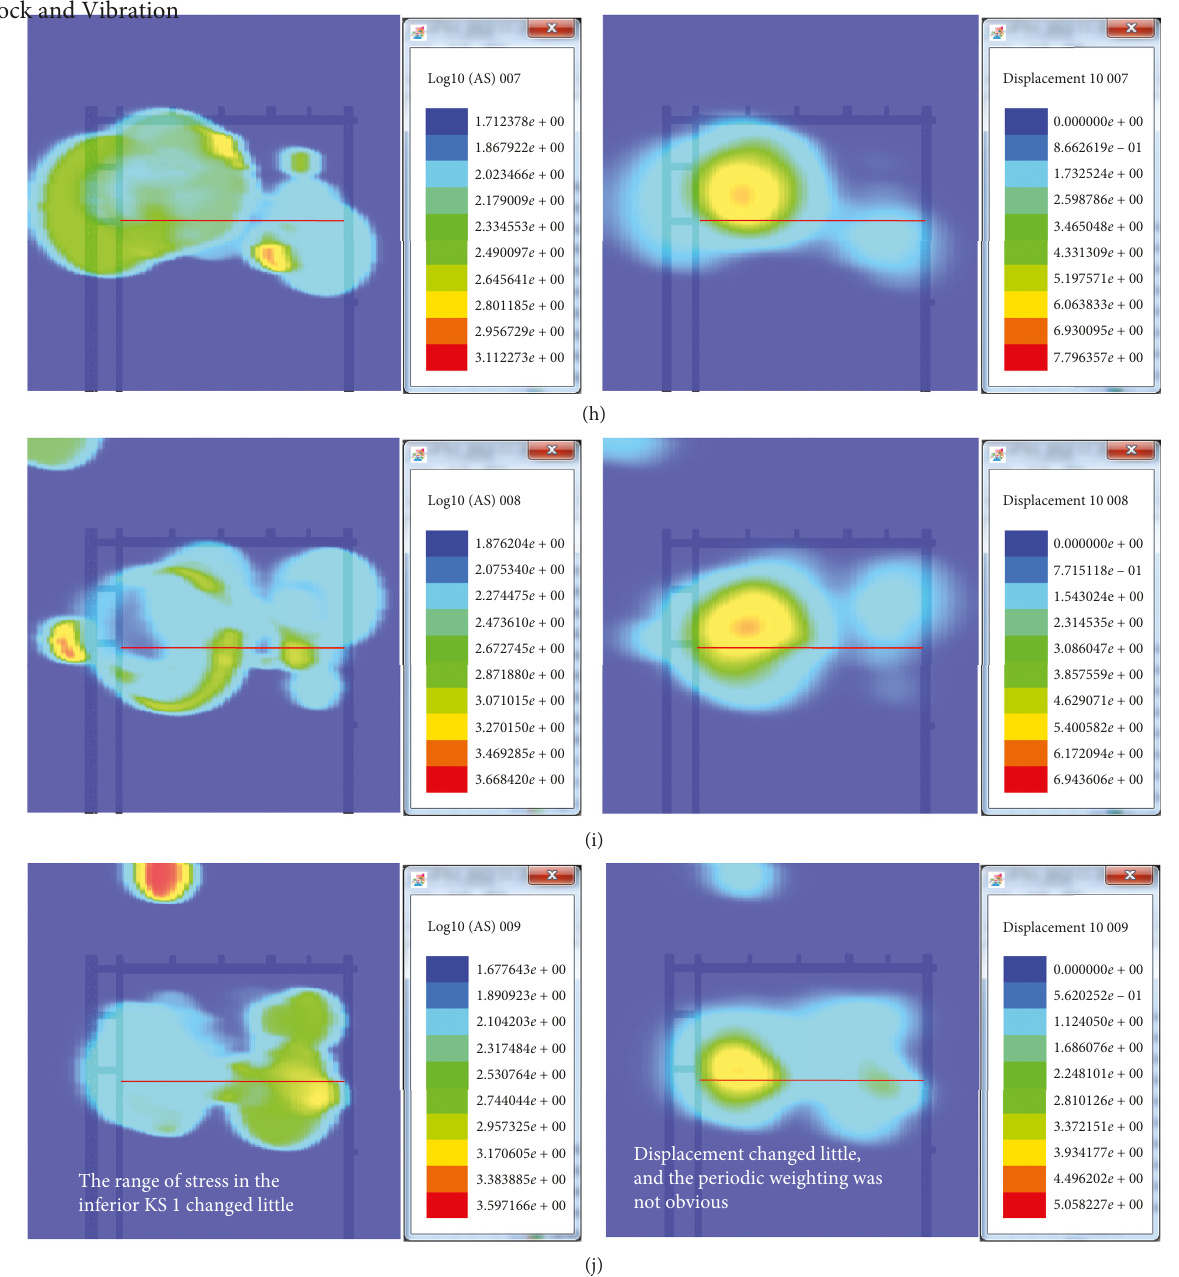
Figure 6: Cloud charts of apparent stress and displacement in inferior KS 1: (a) Aug 31, (b) Sep 1, (c) Sep 3, (d) Sep 4, (e) Sep 5, (f) Sep 6, (g) Sep 7, (h) Sep 8, (i) Sep 9, and (j) Sep